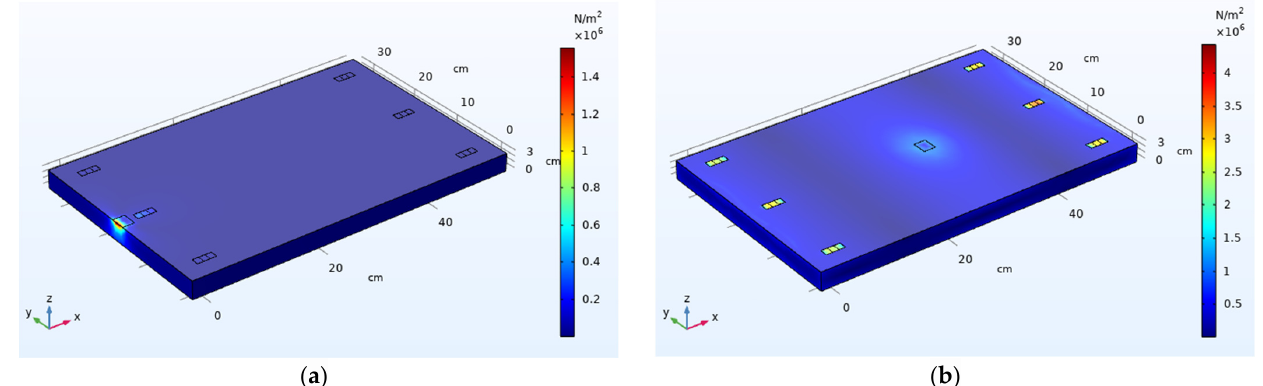
Figure 4. ( a ) Von Mises stress distribution for a 40 kg load applied at x = 0 cm (edge of the structure); ( b ) Von Mises stress distribution for a 40 kg load applied at x = 30 cm from the structure’s fixed edge.